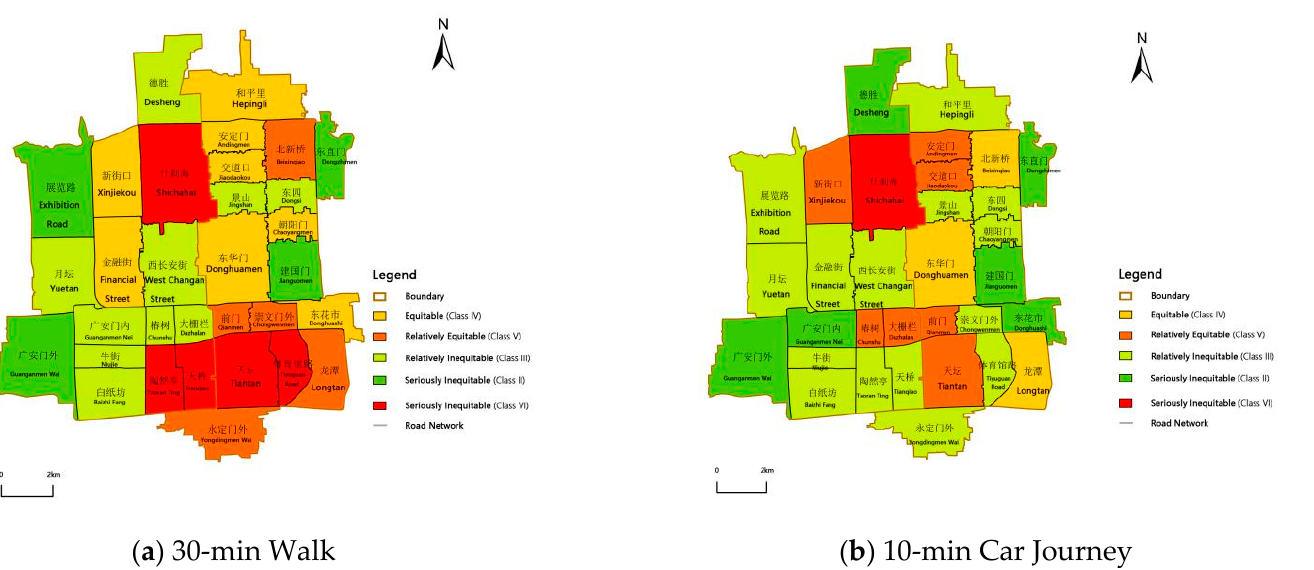
Figure 7. Equity value at district level. ( a ) Equity values at district level for 30-min walk; ( b ) equity values at district level for 10-min car journey.